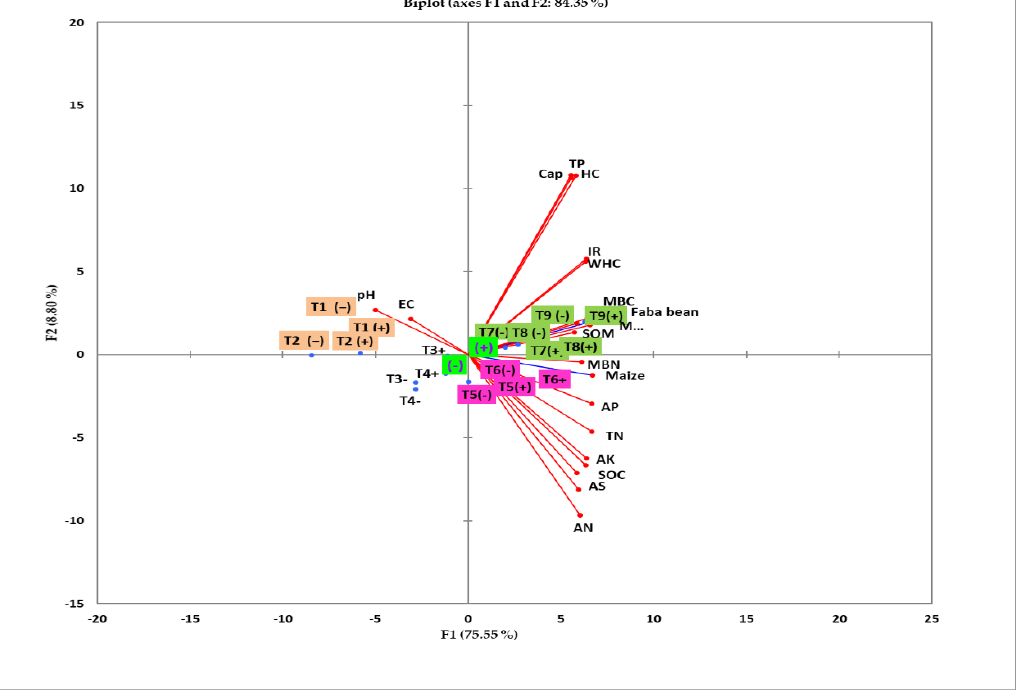
Figure 3. Biplot of the principle component analysis for the first two principle components of effects of different integrated nutrient management (INM) with (+) and without (−) seed inoculation on soil chemical (pH, EC, soil organic matter (SOM), soil organic carbon (SOC) total nitrogen (TN), available of N (AN), P (AP), K (AK), and S (AS), soil physical (capillary (Cap), total porosity (TP), hydraulic conductivity (HC), water-holding capacity (WHC), and infiltration rate (IR)) soil biological (soil microbial biomass carbon (MBC), nitrogen (MBN), and phosphorous (MBP)) properties, and grain yield of faba bean and maize. T1, T2, T3, T4, T5, T6, T7, T8, and T9 indicate the treatments of full recommended NPK, compost of cow manure at 5 t ha − 1 , compost of poultry litter manure at 5 t ha − 1 , compost of mixture of sheep and camel manure at 5 t ha − 1 , 50% NPK + 5 t ha − 1 mixture of three types of compost, 50% NPK + 10 t ha − 1 mixture of three types of compost, mixture of three types of compost at 10 t ha − 1 , mixture of three types of compost at 15 t ha − 1 , and mixture of three types of compost at 20 t ha − 1 , respectively.